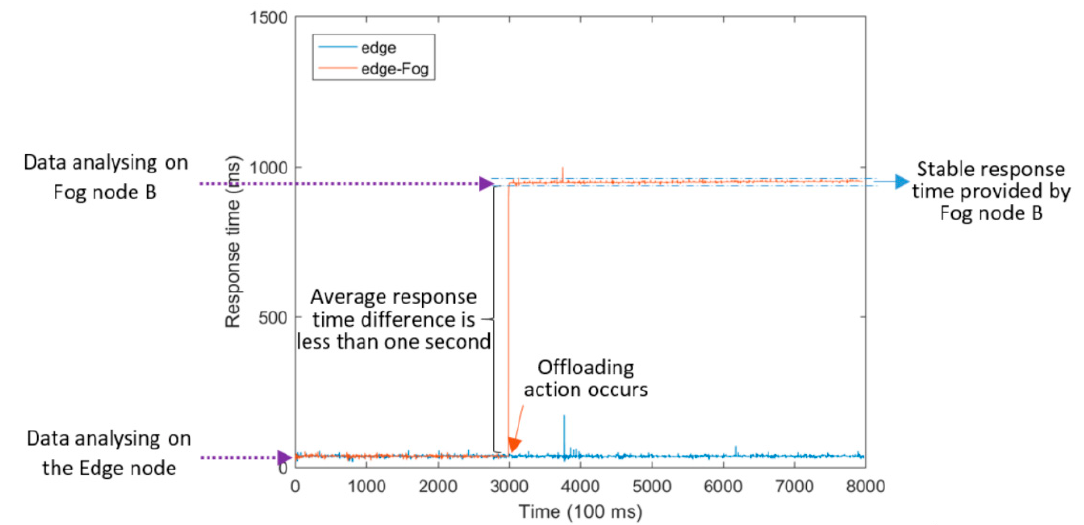
Figure 10. Service response time provided by our proposed capillary computing architecture.